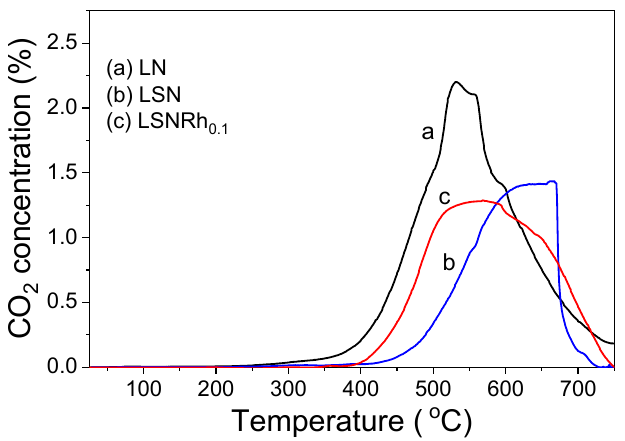
Figure 8. Temperature-programmed oxidation (TPO) profiles obtained for the indicated catalysts following exposure to the long-term stability tests shown in Figure 7.